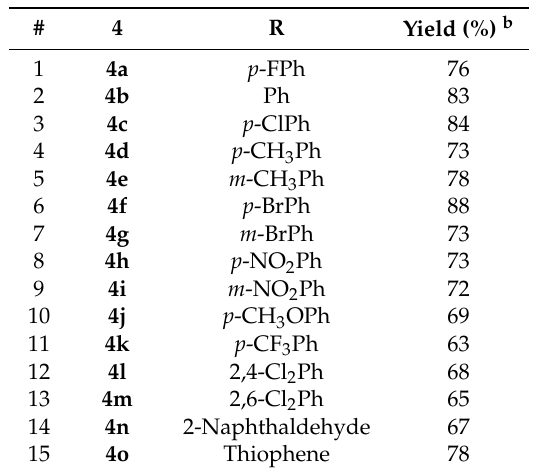
Table 1. Synthesis of 4a – o with different various aldehydes a .